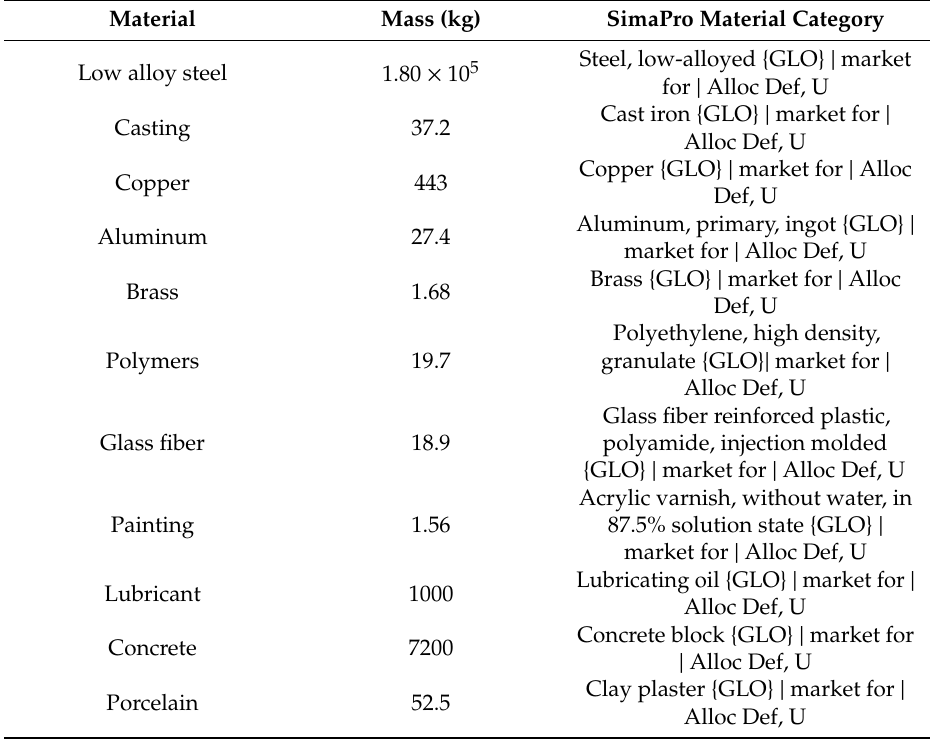
Table A2. Substation Components V112 Turbines.